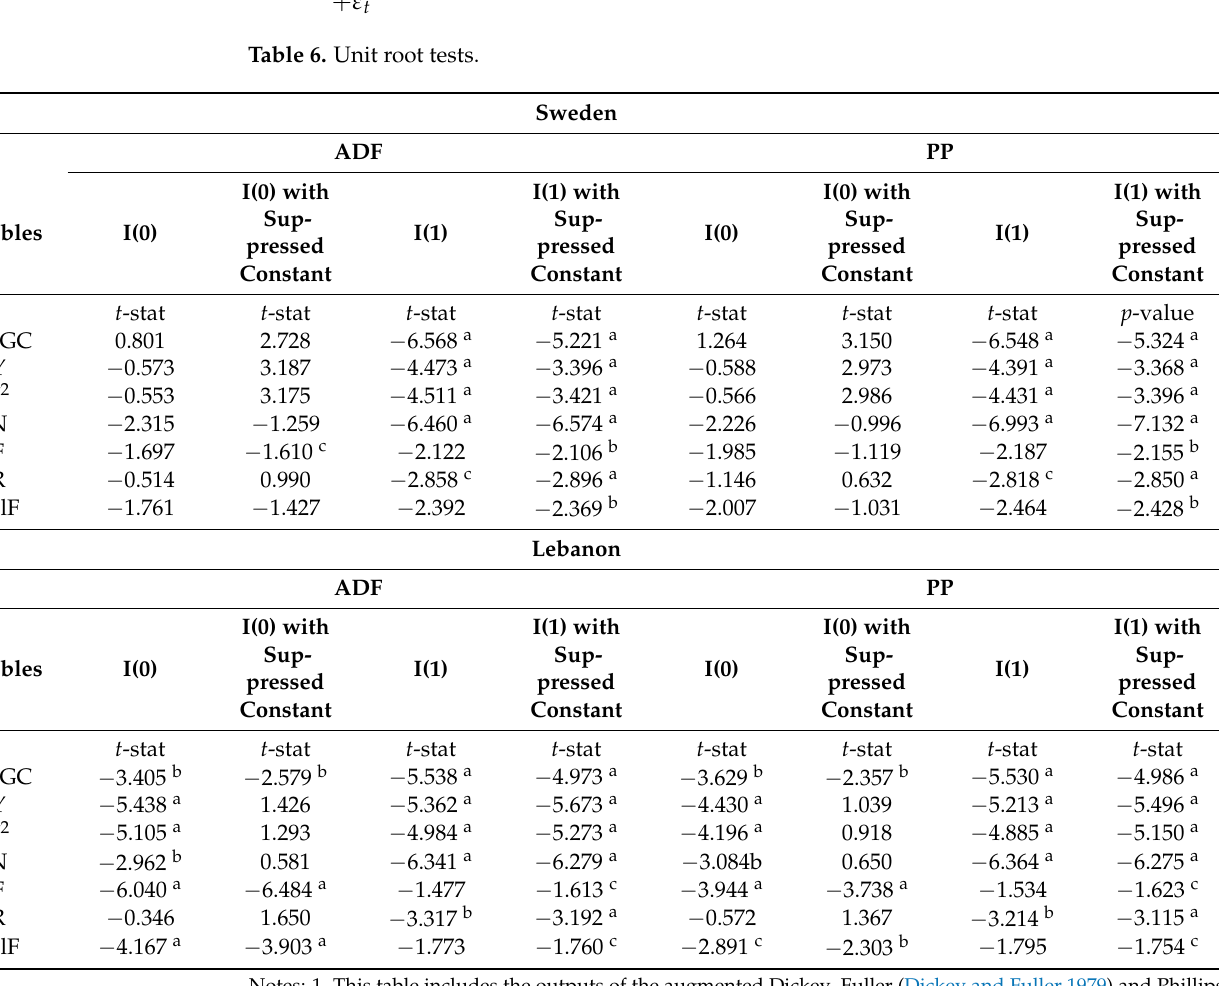
Table 6. Unit root